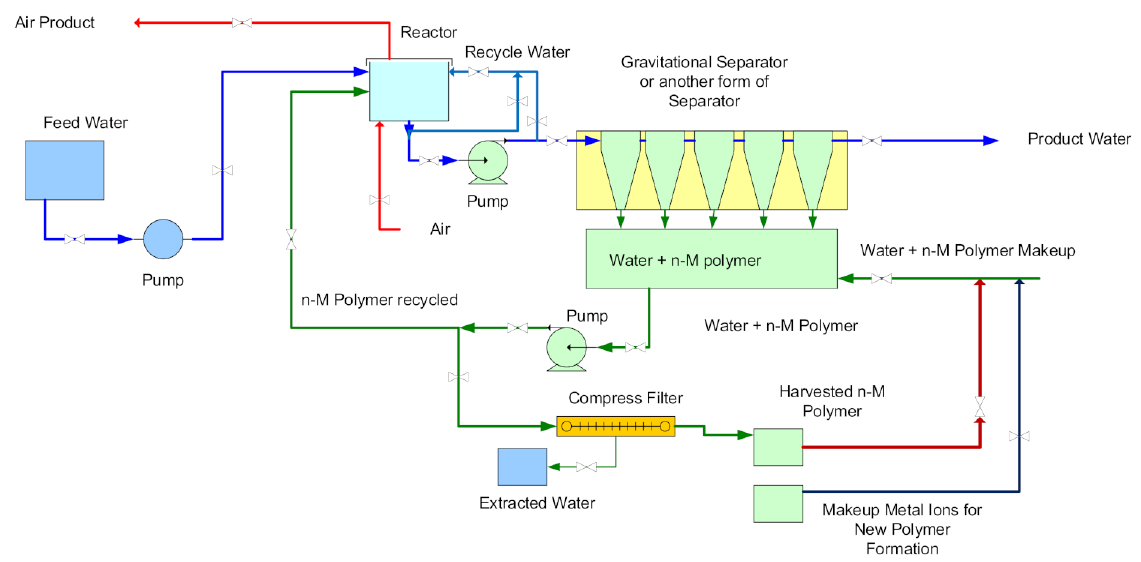
Figure 20. Possible reactor process flow where the reactor is used to remediate